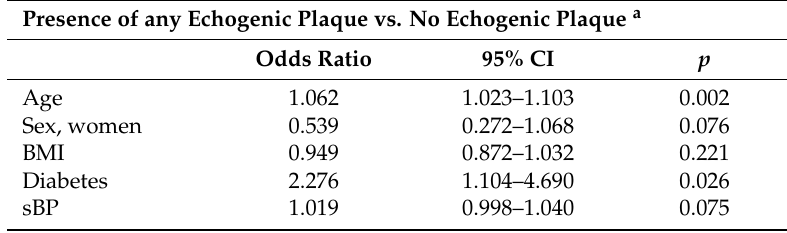
Table 2. Logistic regression model for the presence of any echogenic plaques. Presence of any Echogenic Plaque vs. No Echogenic Plaque